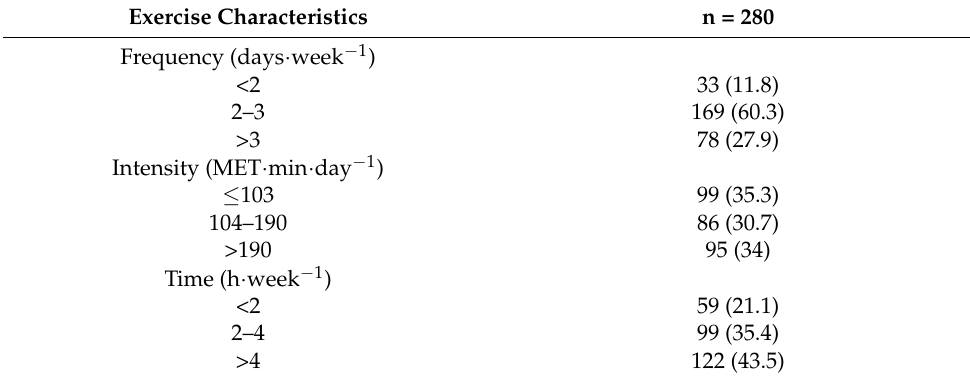
Table 2. Cohort exercise